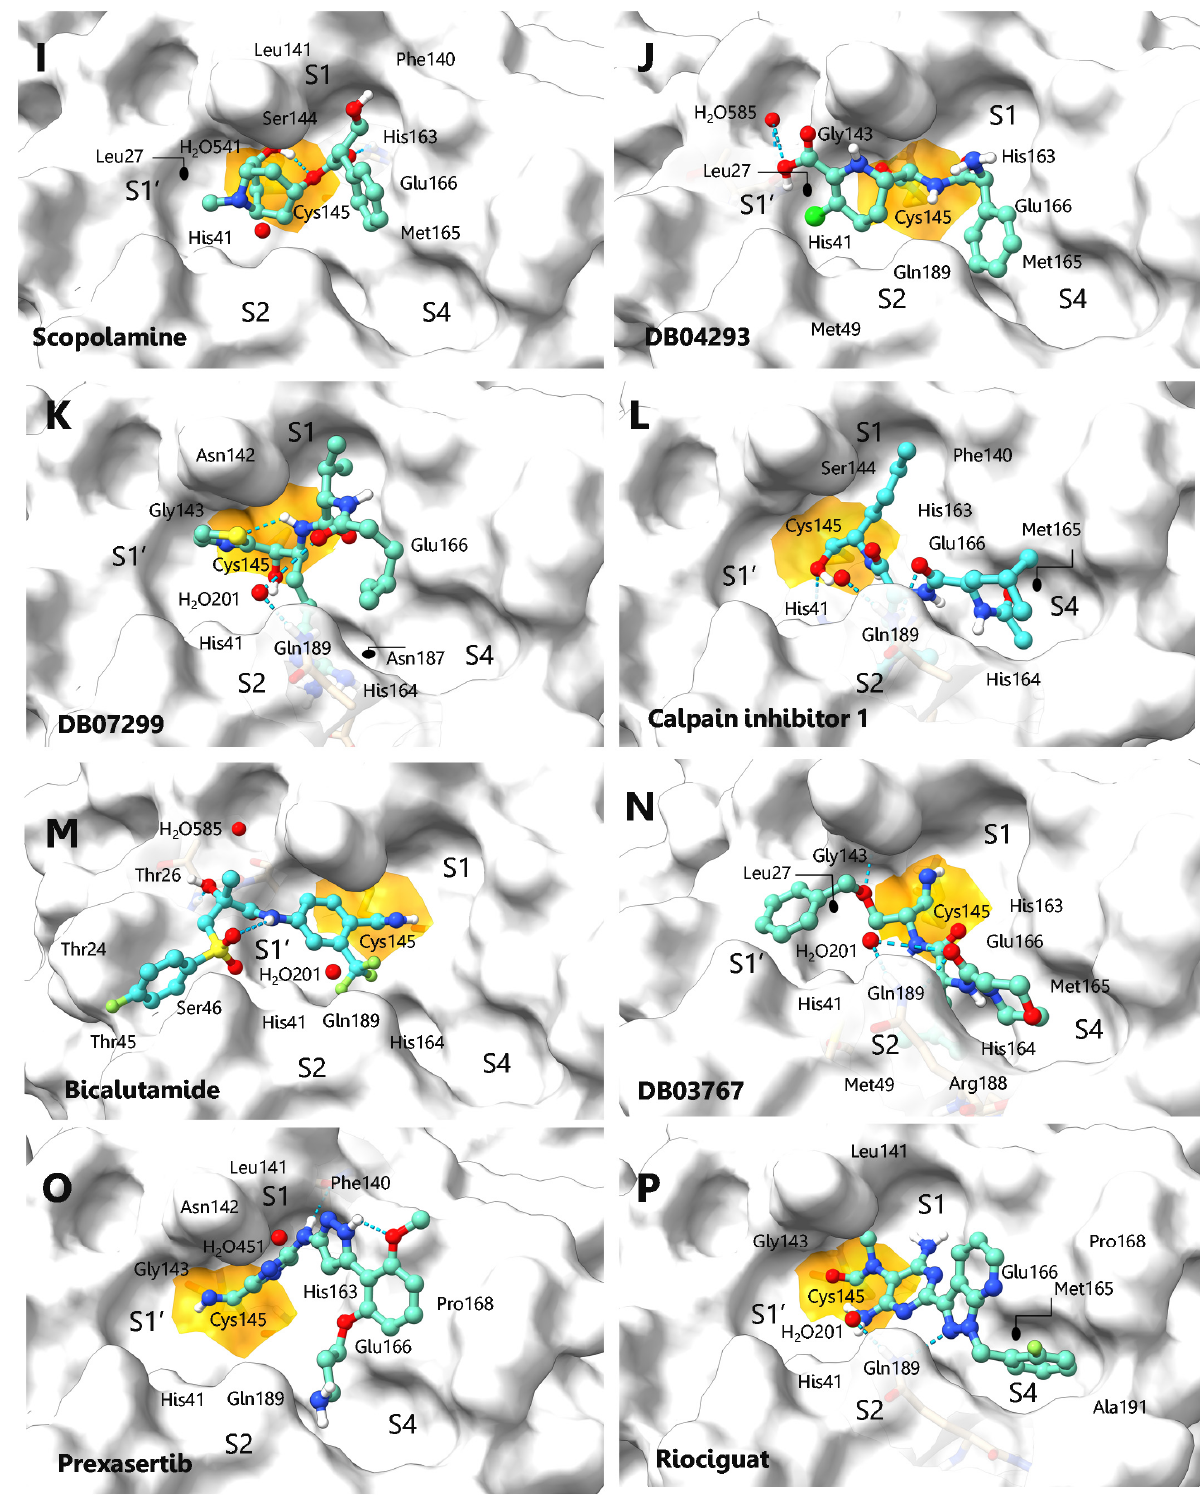
Figure 5. Binding pose of the top-ranked drugs after CsScore, ( A ) Vaborbactam, ( B ) DB04234, ( C ) DB03456, ( D ) Cimetidine, ( E ) Ixazomib, ( F ) CMX-2043, ( G ) DB07224, ( H ) DB07225, ( I ) Scopolamine, ( J ) DB04293, ( K ) DB07299, ( L ) Calpain inhibitor-1, ( M ) Bicalutamide, ( N ) DB03767, ( O ) Prexasertib, and ( P ) Riociguat. The covalent interaction generated by the Cys145 residue of M pro with the electrophilic warhead of each molecule is shown in orange and the hydrogen bonding are represented in cyan segmented